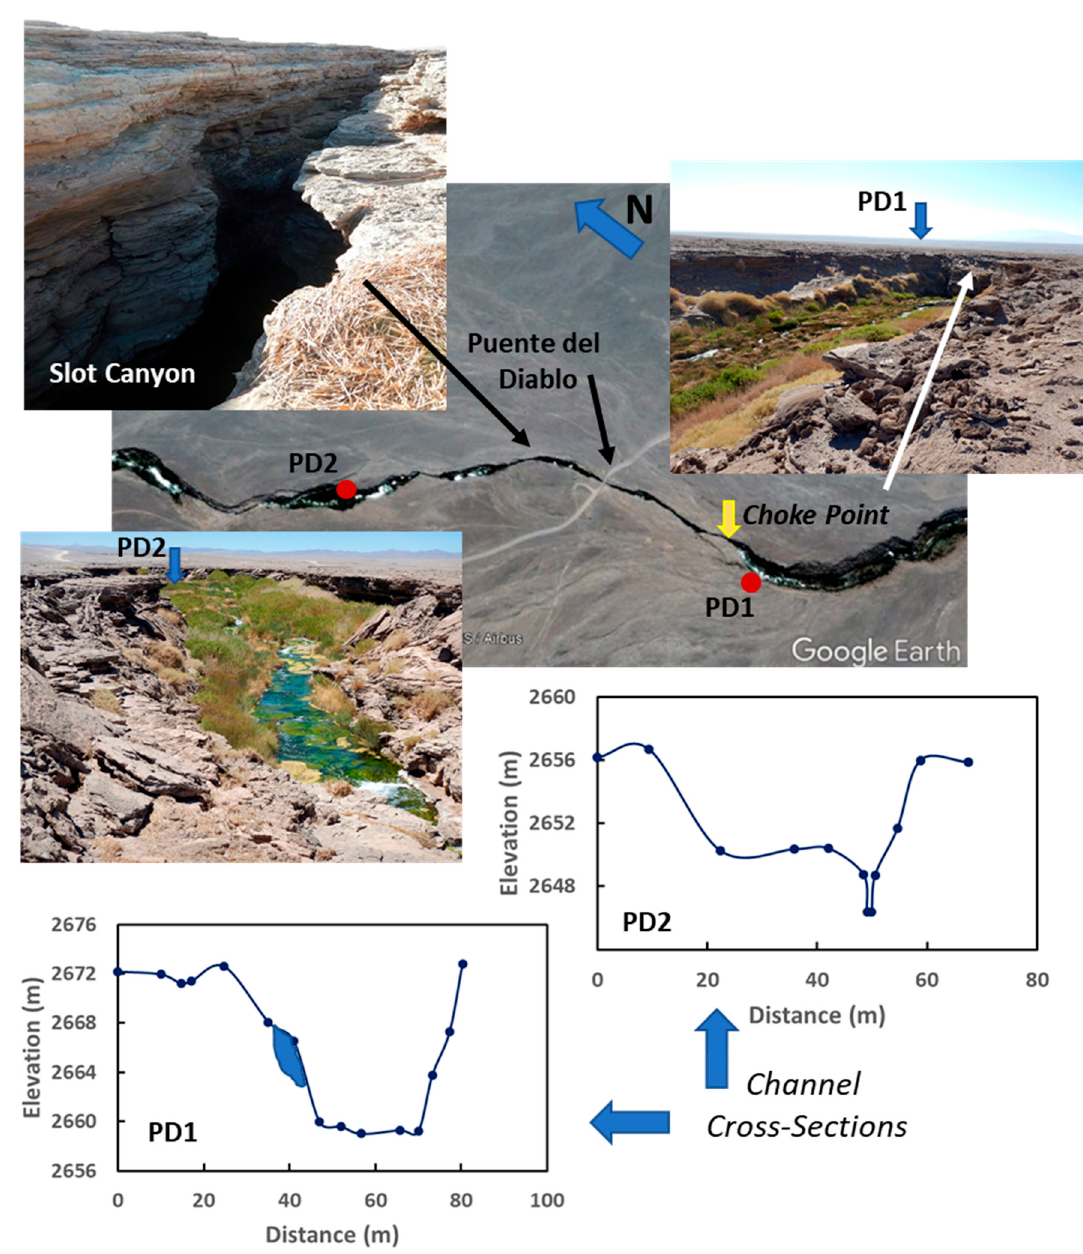
Figure 2. Geomorphic characteristics of reach PD (center image from Google Earth, 10 / 5 / 2016, Image © 2019 CNES / Airbus). Upper right photograph was taken looking downstream at the slot canyon. Lower right photograph was taken looking upstream toward the slot canyon.